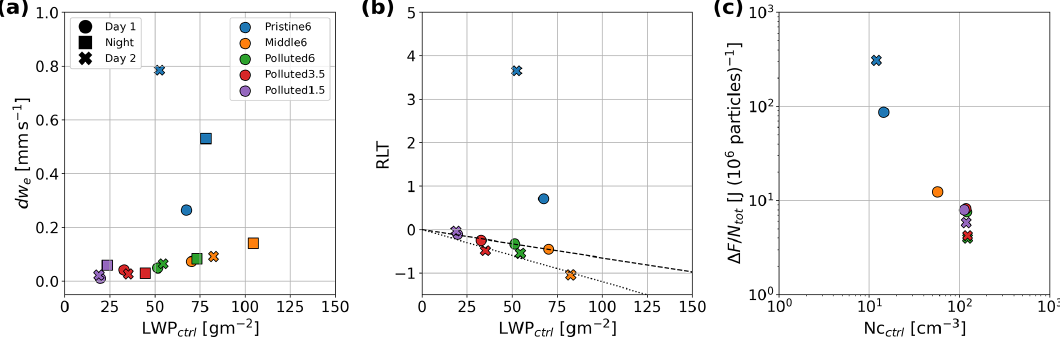
Figure 11. (a) Sensitivity of d w e to the LWP ctrl . The circle, square, and cross markers represent Day 1, Night, and Day 2 averages, respectively. Panel (b) is the same as (a) but for the sensitivity of RLT to the LWP ctrl . (c) Sensitivity of brightening efficiency (i.e., the radiative forcing per 10 6 particles) to N c , ctrl